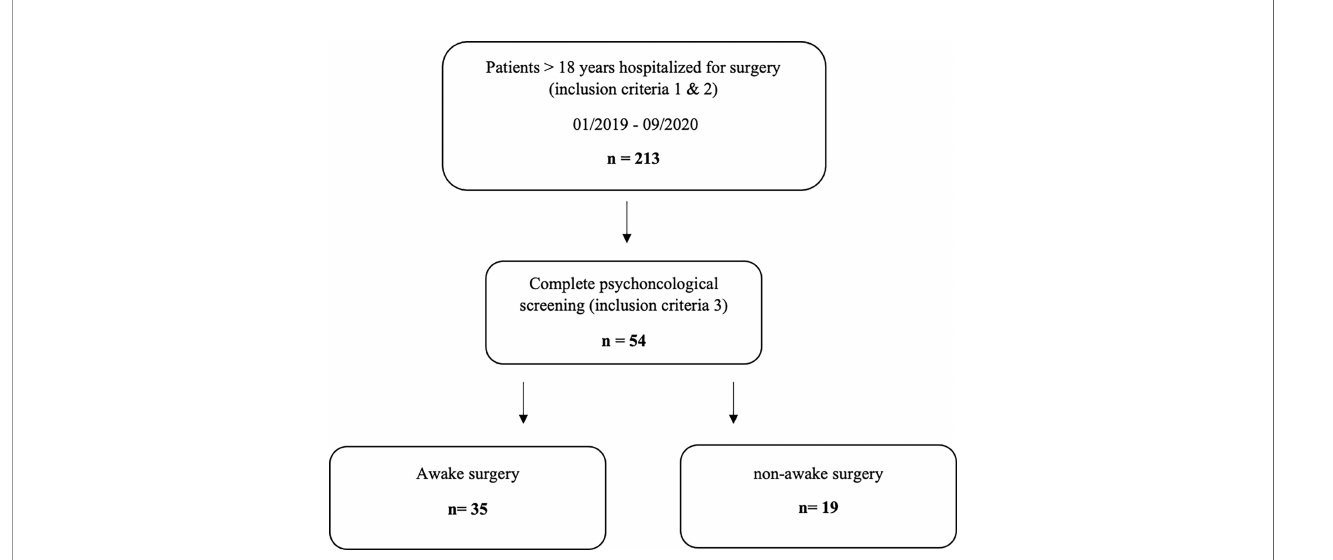
FIGURE 1 | Flowchart describing patient selection.